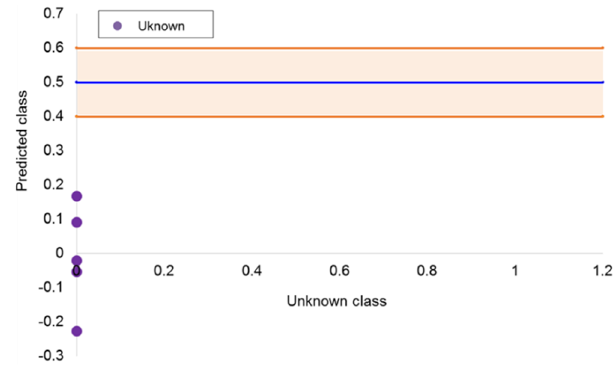
Figure 5. Class predictions plot for the samples from the European countries other than Spain.